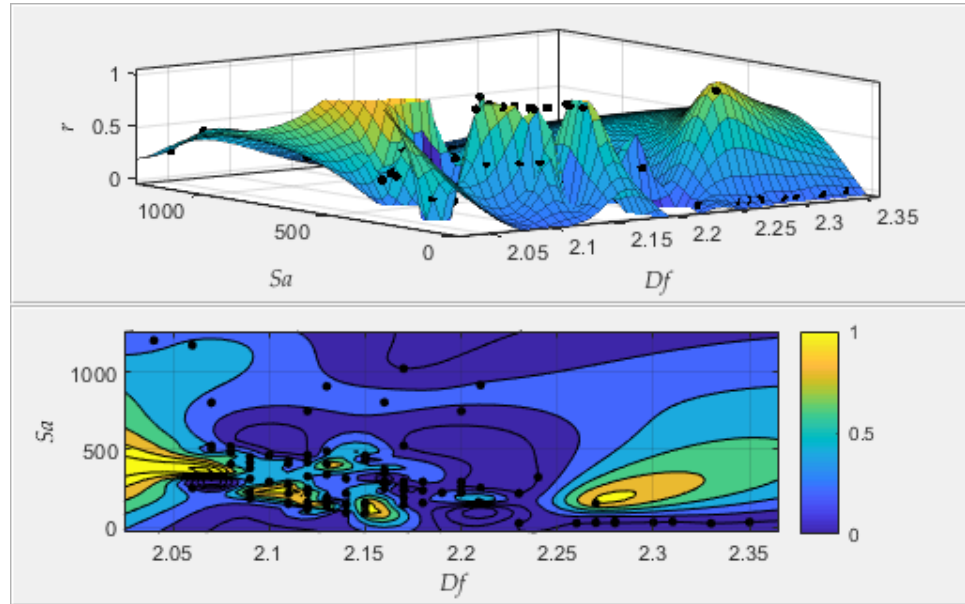
Figure 16. Relationship between Df , Sa and r values.